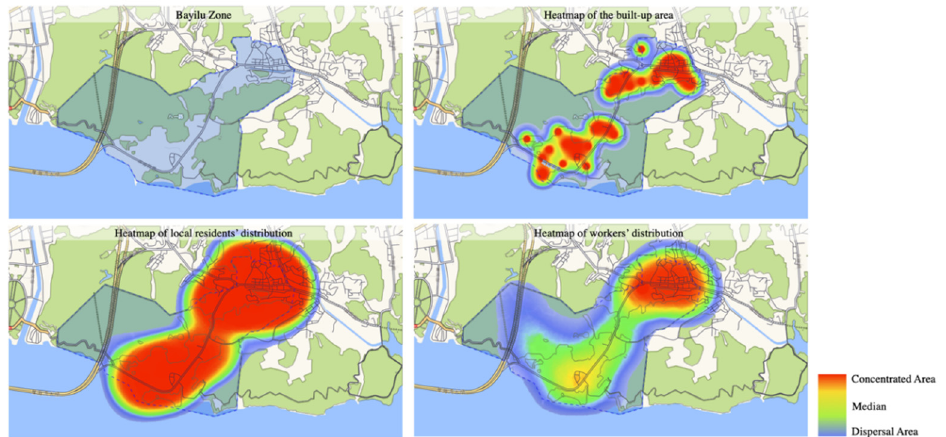
Figure 6. Heatmaps of Bayilu Zone. Source: Authors.